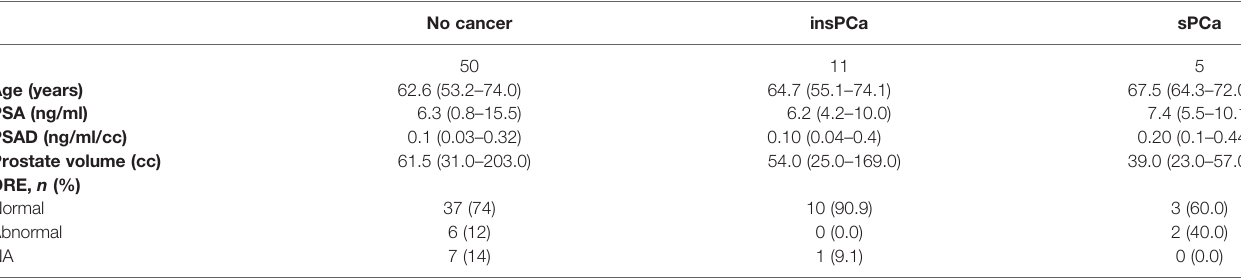
TABLE 2 | Clinical characteristics of men with negative multiparametric prostate MRI (PI-RADS 1 – 2).